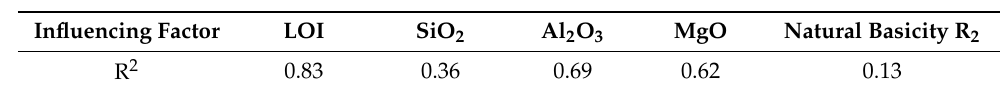
Table 6. Fitting degree of each influencing factor.